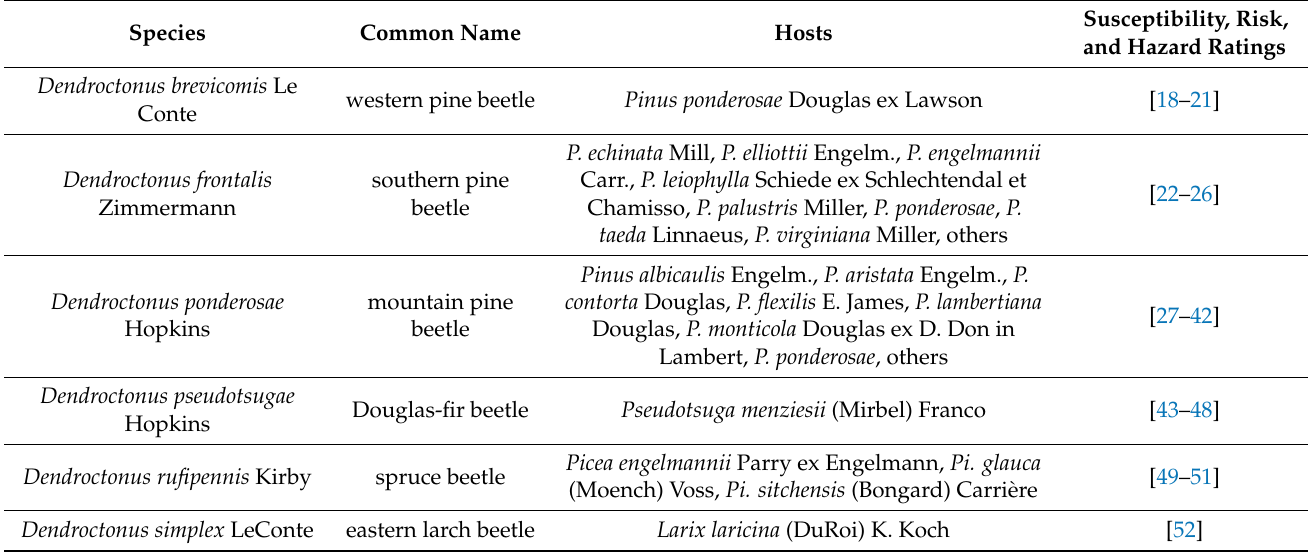
Table 1. Important Dendroctonus spp., their known hosts, and a subset of publications related to susceptibility, risk, and